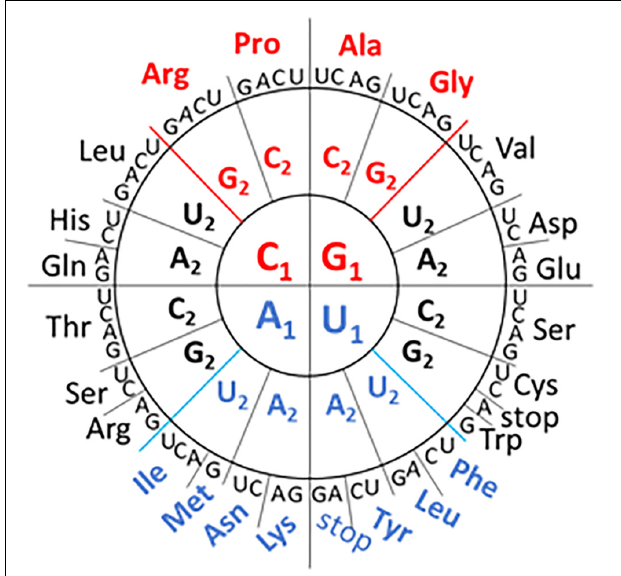
FIGURE 1 | Codon Wheel adapted from Grosjean and Westhof (2016). The first nucleotide (N1) of the codon is displayed in the inner circle, the second nucleotide (N2) in the middle circle, and the third nucleotide (N3) in the outer circle with the encoded amino acid three letter code. GC-rich codons (in the first two positions) with “strong” network interactions are shown in red font and the AU-rich codons with “weak” network interactions are shown in blue font. The remaining codons are classified as having “intermediate” network